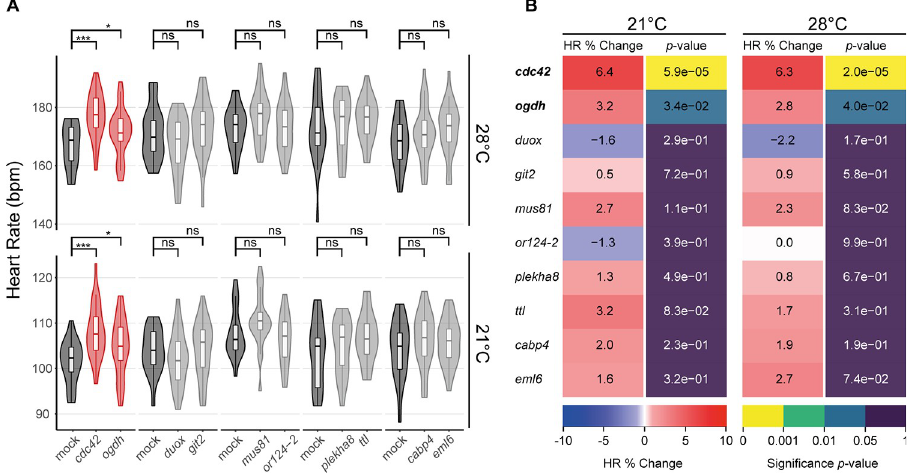
Fig 2. Baseline probability of heart rate phenotype assessed via in vivo targeting of randomly selected genes. (A) Heart rate measurements (beats per minute, bpm) of GFP -injected (Mock) and corresponding sibling crispant embryos (4 dpf) at 21 and 28˚C after developmental focusing. Different experimental plates are represented by breaks on the x-axis. Significant differences in mean heart rates were determined between each crispant embryo group and its corresponding sibling control group by two-tailed Student’s t-test; � p < 0.05, ��� p < 0.001, ns (not significant). Crispants showing significant heart rate phenotype (red), GFP -injected controls (Mock; dark grey), crispants showing no significant heart rate phenotype (light grey). (B) Heatmap quantitative representation of the data shown in (A); for each measured temperature, the percent change in mean heart rate (HR % Change) between crispants and their corresponding control sibling, flanked by the statistical significance ( p -value) of the observed change calculated by two-tailed Student’s t-test on the full distribution in (A). Genes showing significant heart rate phenotypes are indicated in bold . For biological replicates see Source Data S3 Fig in S1